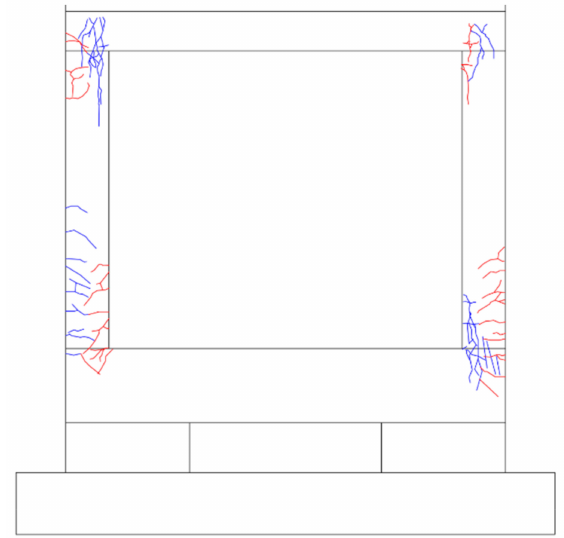
Figure 15. Cracks of test frame with no reinforcement applied (PD-FR) at the final stage (200 cm/s 2 ). In this test frame retrofitted with NBSD (PD-NBSD-WSCS), fine initial flexural cracks started to occur at the lower part of the columns at around 1.88 s (3.5 mm) when the input seismic ground motion was set to 200 cm/s 2 (Figures 16 and 19a). Subsequently, at 2.61 s (12.7 mm), these flexural cracks increased in number, but their size remained limited. At 6.33 s (23.9 mm), where the maximum seismic response occurred, fine flexural cracks also occurred. The pseudo-dynamic testing was conducted for a period of 10 s. The results showed that PD-NBSD retrofitted with NBSD was subject to only fine flexural cracks in contrast to PD-FR with no reinforcement applied, which underwent a shear failure, when the input seismic ground motion was 200 cm/s 2